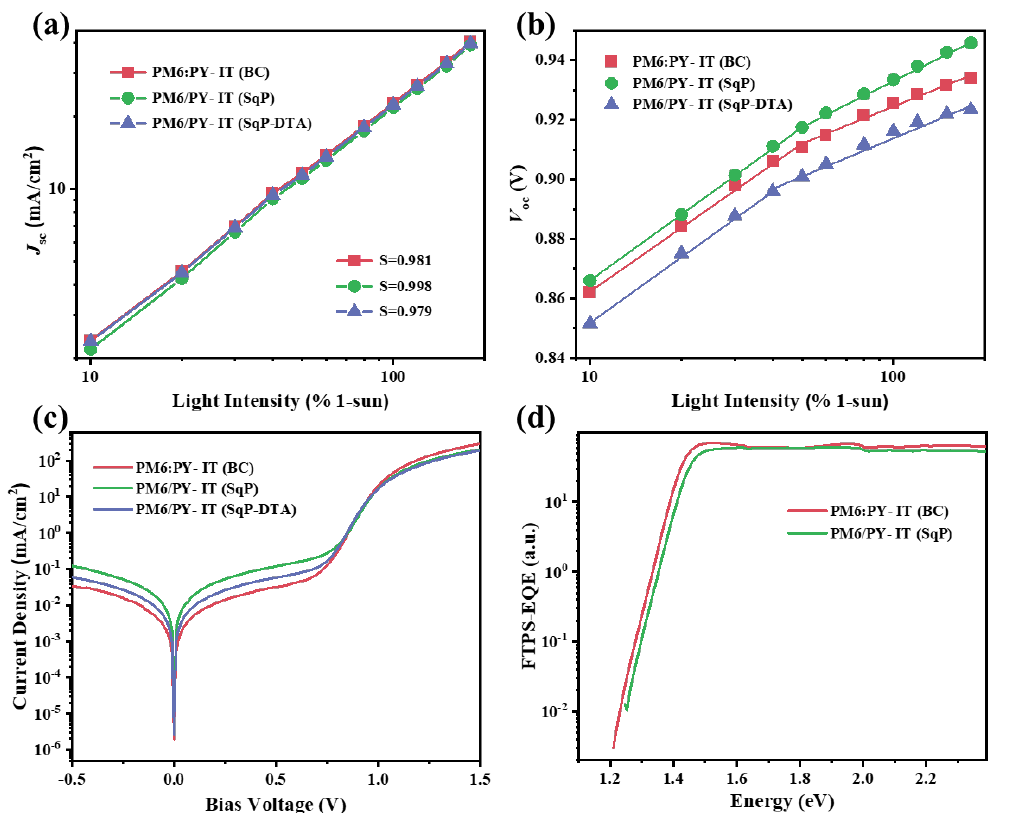
Figure 3. ( a ) J SC versus light intensity, ( b ) V OC versus light intensity, ( c ) dark J ‐ V curves, and ( d ) FTPS ‐ EQE spectra measured from 500 to 1800 nm.